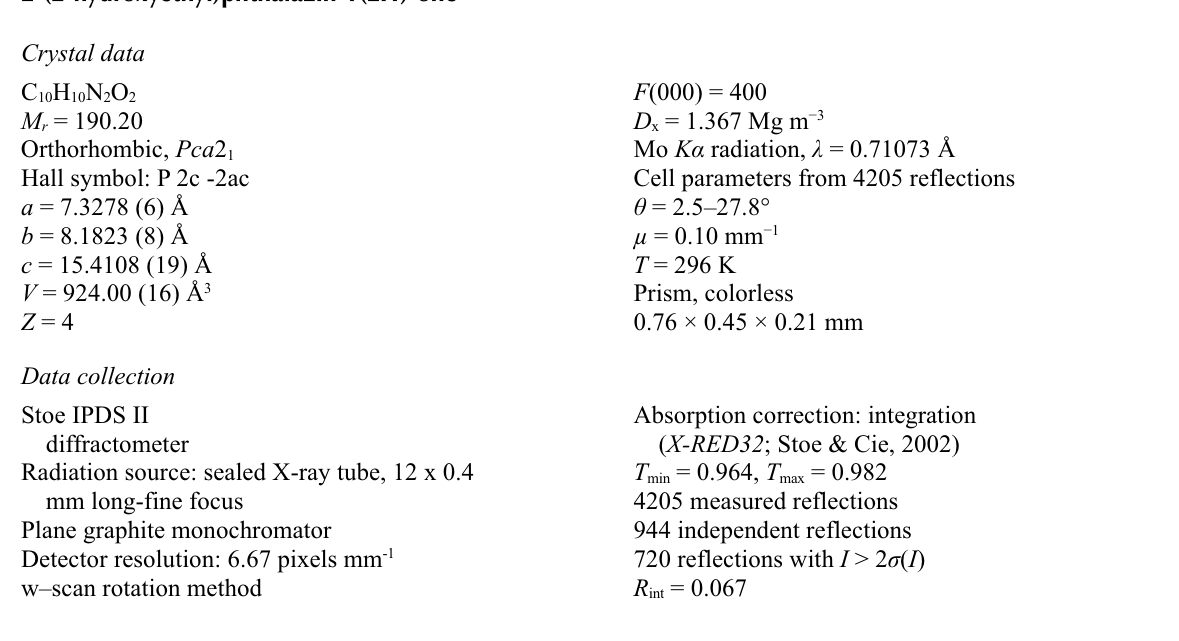
A packing diagram of (I), showing the π ··· π interactions [symmetry code: (i) x, y - 1, z]. Cg1 and Cg2 denote the centroids of the rings. Hydrogen bonds are shown as dashed lines. H atoms not involved in hydrogen bondings have been omitted for